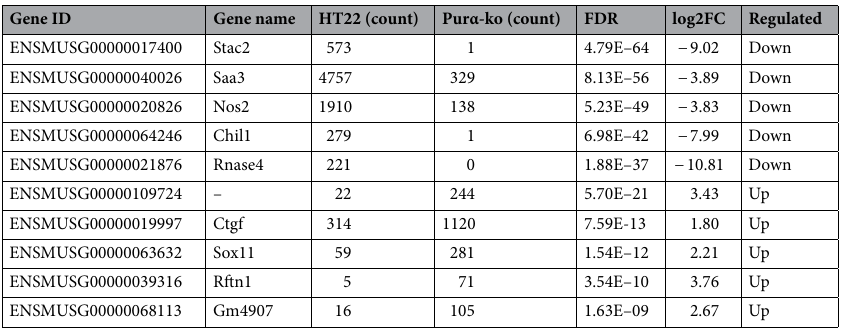
Table 1. The list of top5 up-regulated and down-regulated